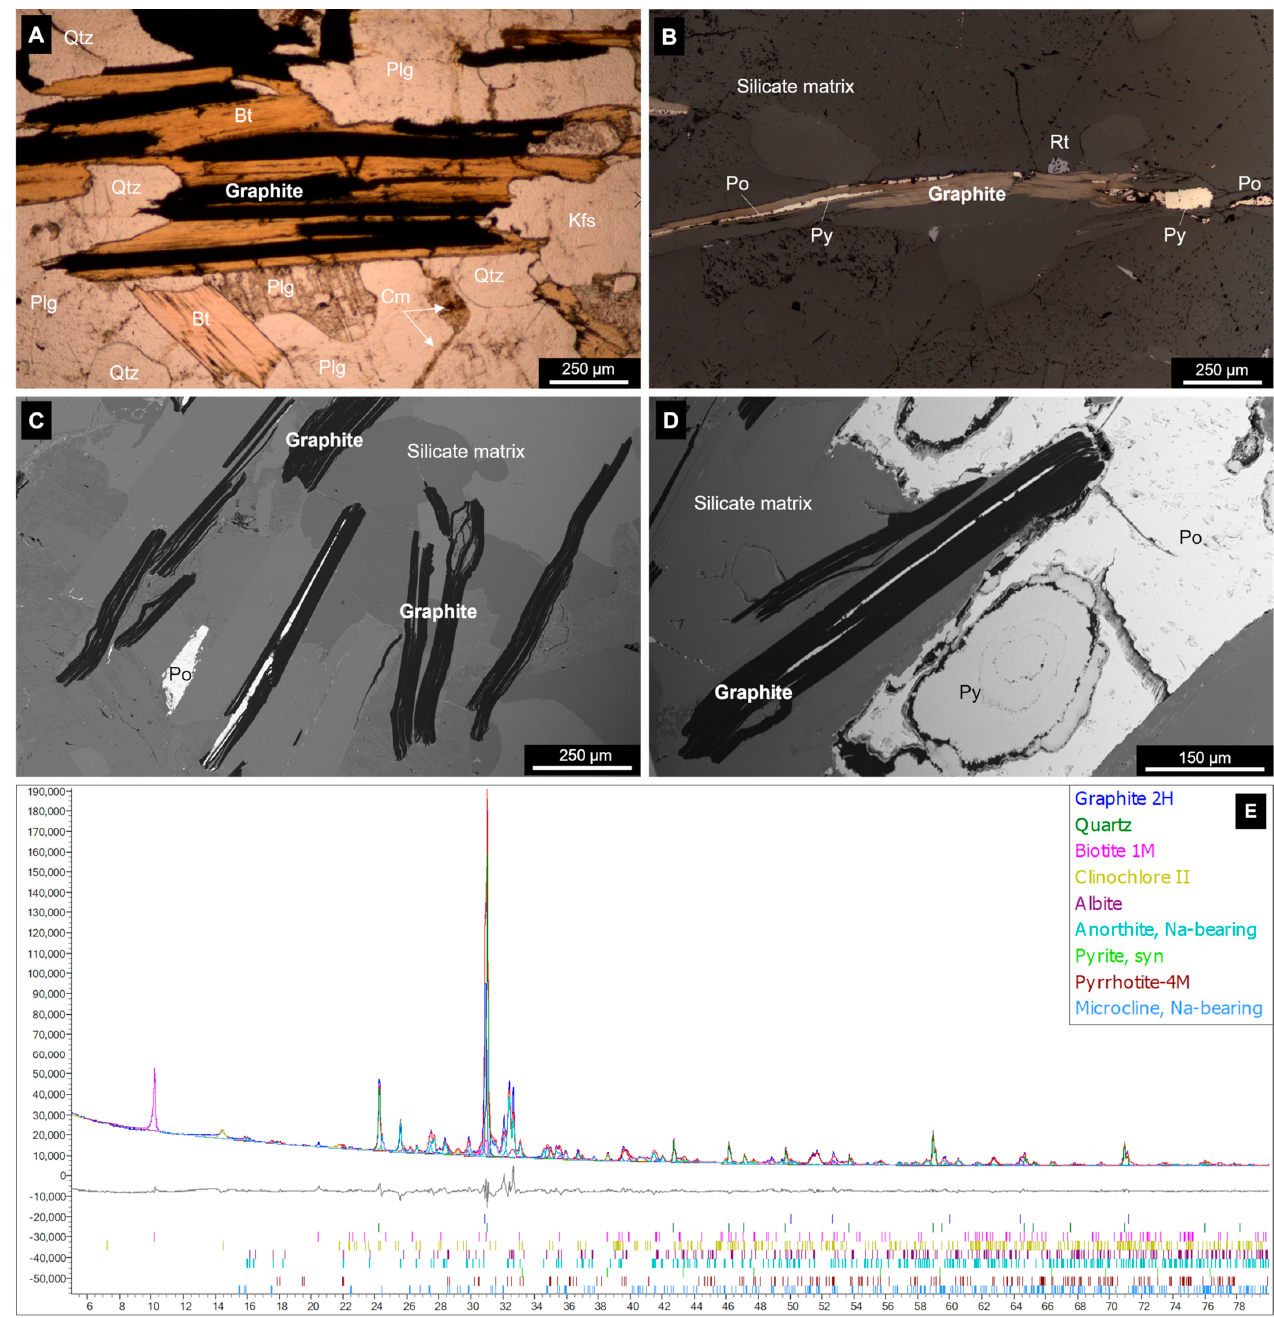
Figure 4. OM ( A , B ), SEM images ( C , D ) and ( E ) XRD patterns of the flake graphite ore sample. ( A ) Parallel aligned graphite flakes intergrown with biotite. Graphite flakes are embedded in a silicate matrix comprising quartz, plagioclase (anorthite and albite), biotite and alkali feldspar (microcline). Secondary clay minerals occasionally replace plagioclase and appear along grain boundaries (transmitted light, PPL). ( B ) Disseminated super jumbo flake with intergrowth of pyrite and pyrrhotite along basal cleavage planes embedded in silicate matrix. Pyrite, pyrrhotite and rutile are also present as subhedral crystals (reflected light, PPL). ( C ) Disseminated parallel to subparallel oriented graphite flakes, partly deformed and broken apart along basal cleavage planes. ( D ) Graphite flake intergrown with a subhedral crystal of pyrrhotite. Note the colloform nodule of pyrite in the pyrrhotite grain. Abbreviations: Po = pyrrhotite, Py = pyrite, Qtz = quartz, Bt = biotite, Kfs = alkali feldspar, Plg = plagioclase, Rt = rutile, Cm = clay minerals, PPL = plane-polarised light.